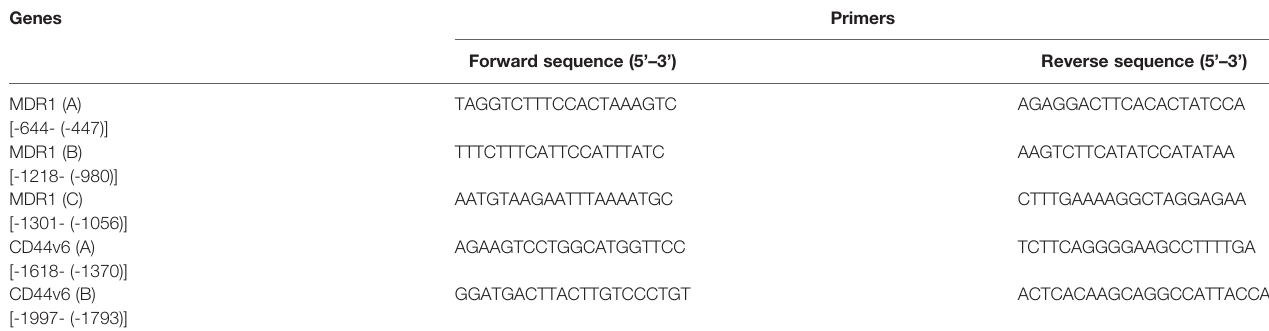
TABLE 7 | ChIP PCR primers for MDR1 and CD44v6